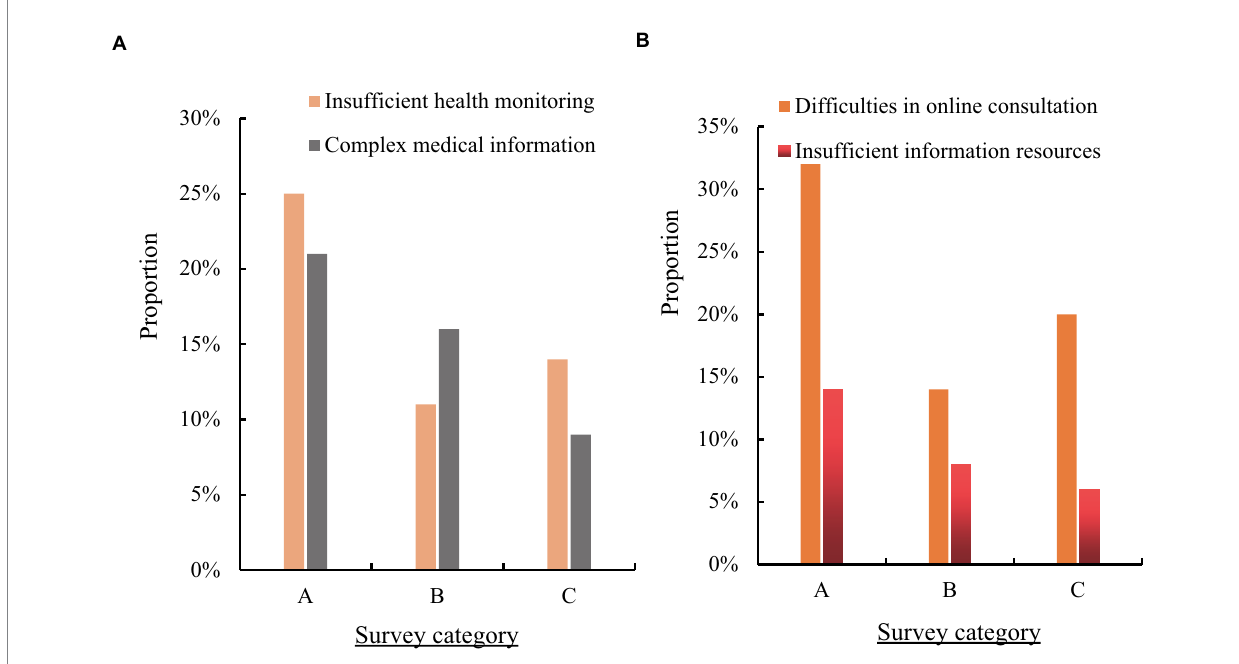
FIGURE 6 The effect of the new public health information system. (A) Insufficient health monitoring and complex medical information. (B) Difficulties in online consultation and insufficient information